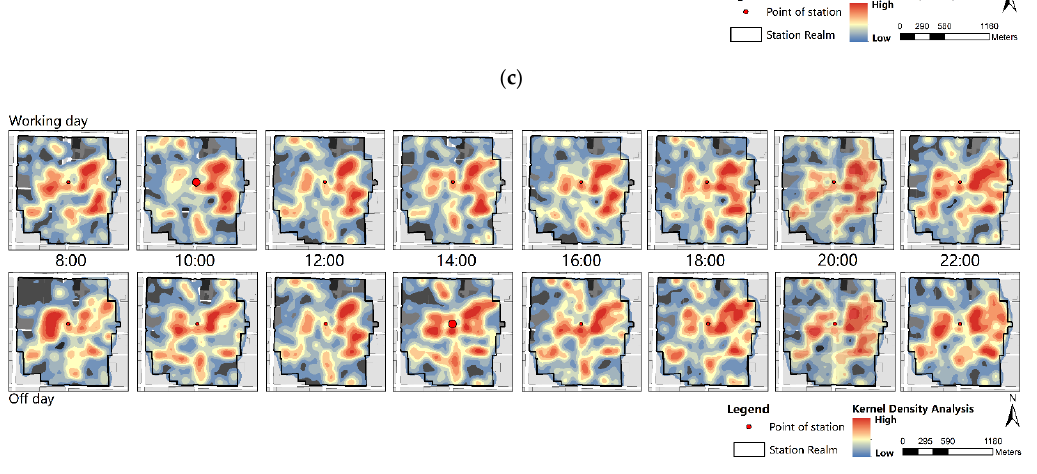
Figure 11. Peak nuclear density of population activity within 500 m of each research station realm: ( a ) XZZX station realm; ( b ) LSY station realm; ( c ) BDJ station realm; ( d ) WYJ station realm. In terms of temporal distribution features, the peak kernel density of population ac- tivities in the four study station realms for each period on working days and off days is shown in Figure 12. During working days, population activity is basically dominated by commuting characteristics, with the morning peak period generally lasting from 7:00 a.m. to 9:00 a.m., and the evening peak mainly concentrated between 6:00 p.m. and 8:00 p.m. On off days, the peak time for population activity is generally at or after 11:00 a.m. This indicates that on off days people choose to be out later compared to working days due to the absence of demands such as work and school. In addition, the mean value of the kernel density of population activity is higher on off days than on working days after 11:00 a.m.,